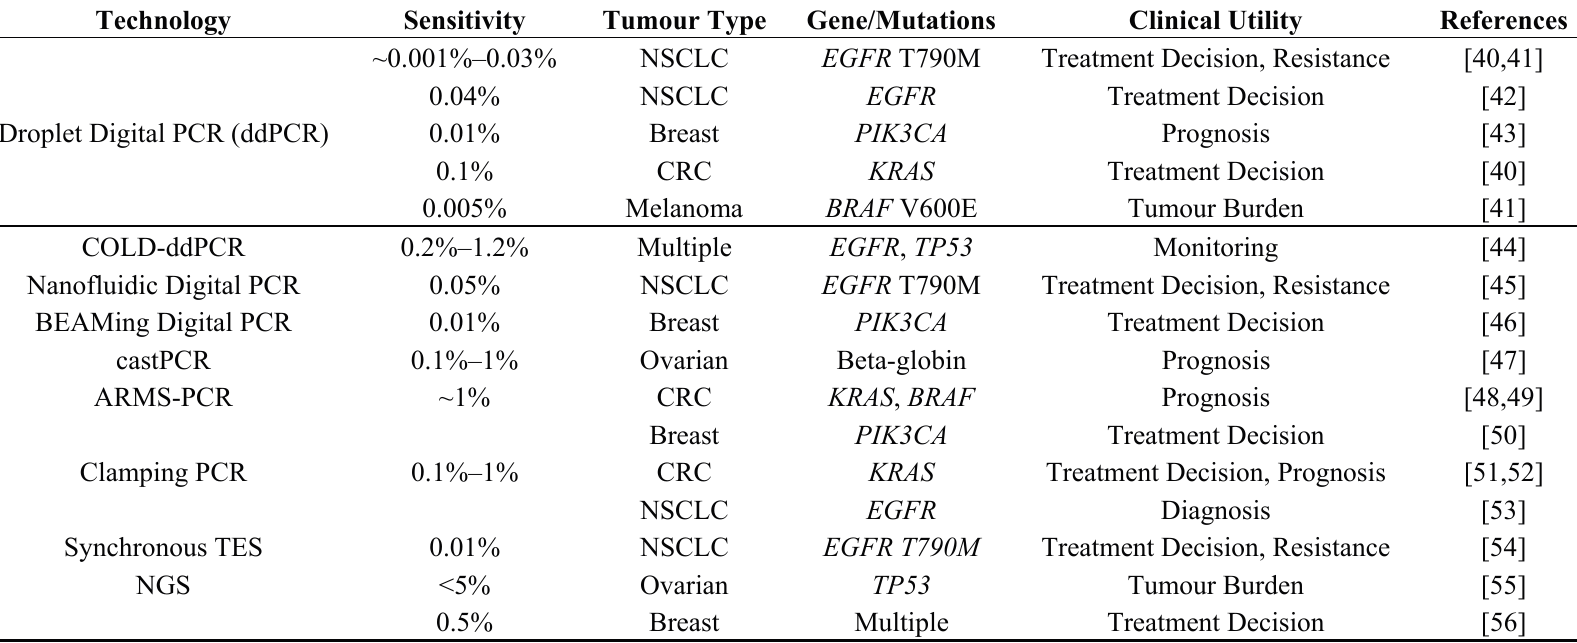
Table 1. Technologies utilised for detection of ctDNA in plasma and examples of use in